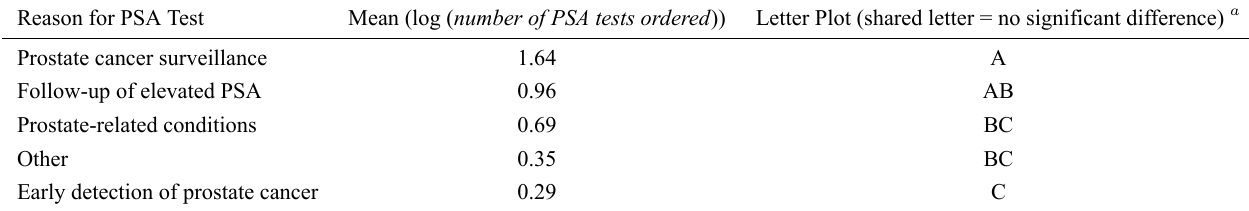
Table 5. Significant differences of PSA ordered vs reason to order the